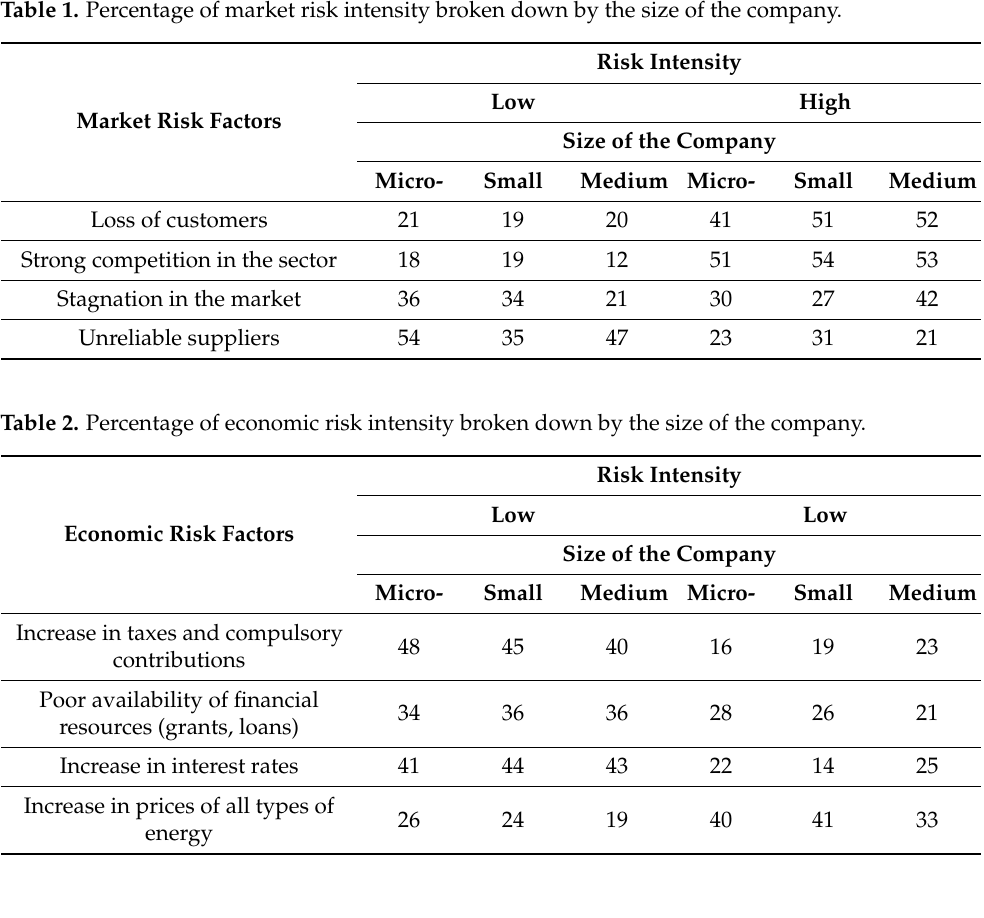
Table 1. Percentage of market risk intensity broken down by the size of the company.